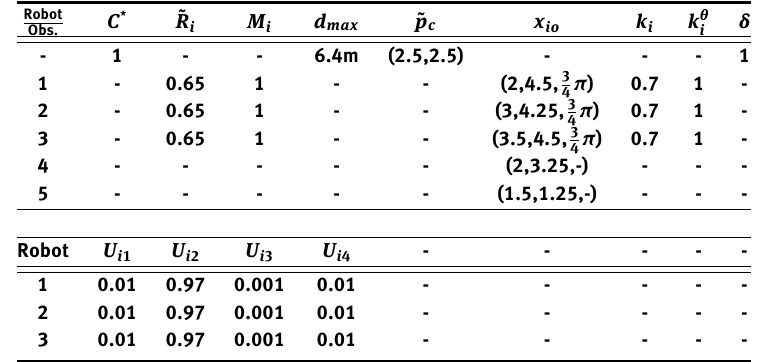
Table 5. Table of Experiment 1 parameters.